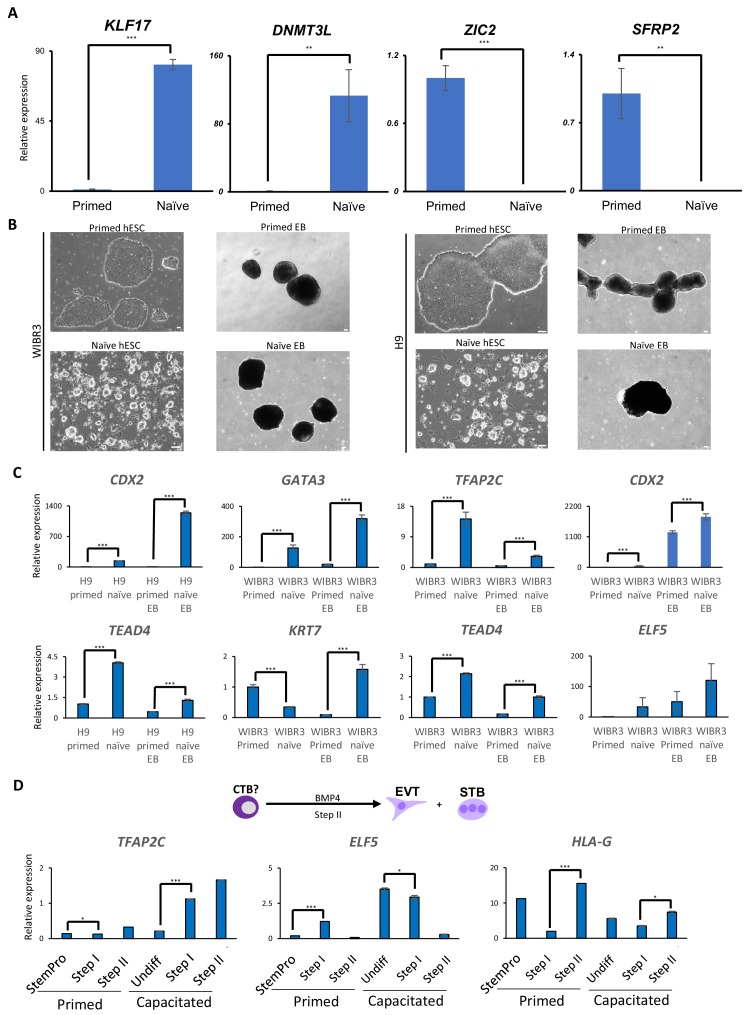
Trophoblast potential of different hPSC states under spontaneous and BMP4-mediated differentiation conditions.(A) Quantitative gene expression analysis for naïve marker genes KLF17 and DNMT3L, and primed marker genes ZIC2 and SFRP2 in H9 primed and naïve hESCs. Error bars indicate ±1 SD of technical replicates. ‘**' indicates a p-value<0.01, and ‘***' indicates a p-value<0.001. (B) Phase contrast images of H9 and WIBR3 primed and naïve hESCs, and EBs generated from the respective hESCs. The scale bars indicate 75 μm. (C) Quantitative gene expression analysis for trophoblast marker genes ELF5, KRT7, TFAP2C, GATA3, CDX2, and TEAD4 in H9 and WIBR3 primed and naïve hESCs, and EBs generated from the respective hESCs. Error bars indicate ±1 SD of technical replicates. ‘***' indicates a p-value<0.001. (D) The experimental scheme of step II protocol for BMP4-mediated terminal EVT and STB differentiation from CTBs (top). Quantitative gene expression analysis for trophoblast marker genes TFAP2C, ELF5, and HLA-G in H9 primed and capacitated hPSCs and trophoblasts differentiated from the respective hESCs. Error bars indicate ± 1 SD of technical replicates. ‘*' indicates a p-value<0.05, and ‘***' indicates a p-value<0.001.